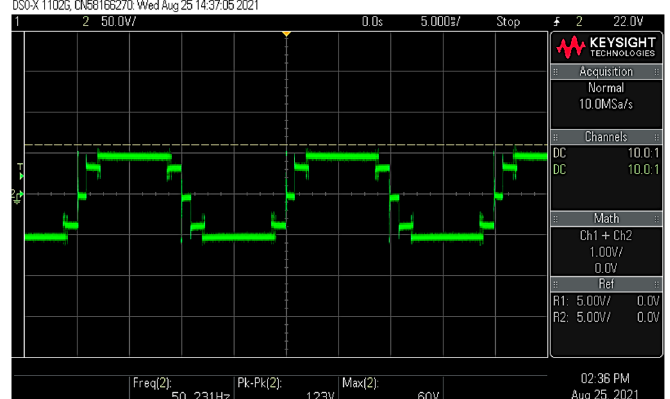
Figure 22. Output voltage waveform (five levels) .